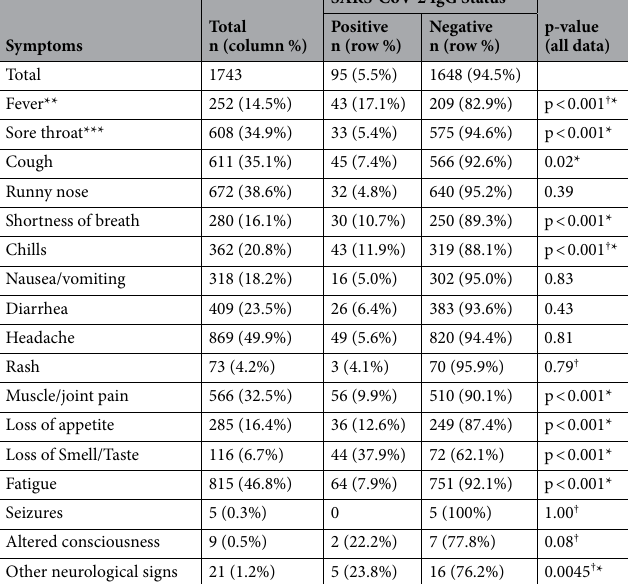
Table 3. Self-Reported symptoms by SARS-CoV-2 IgG status. † Fisher’s Exact Test, otherwise, Chi Squared. *Statistically significant when p-value < 0.05. **Missing data included in analysis due to accounting for 5.2% of responses. ***Missing data included in analysis due to accounting for 5.3% of responses. Column percentages may not always add up to 100% due to missing data. Missing data ranged from